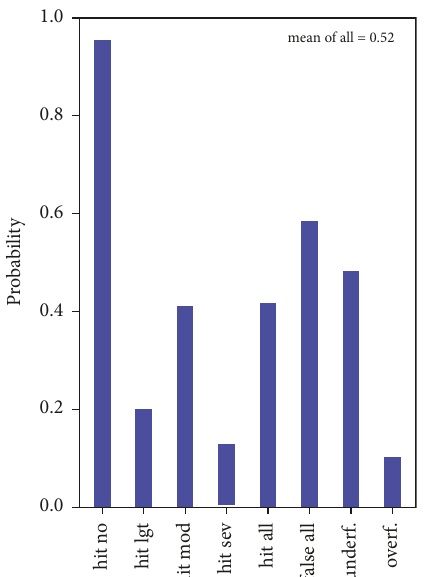
Figure 6: Hit rates of no, light, moderate, and severe icing as well as the total hit rate, false-forecast rate, under-forecasting rate, and over- forecasting rate. Figure 5showsthe bars correspond to the multicategory contingency